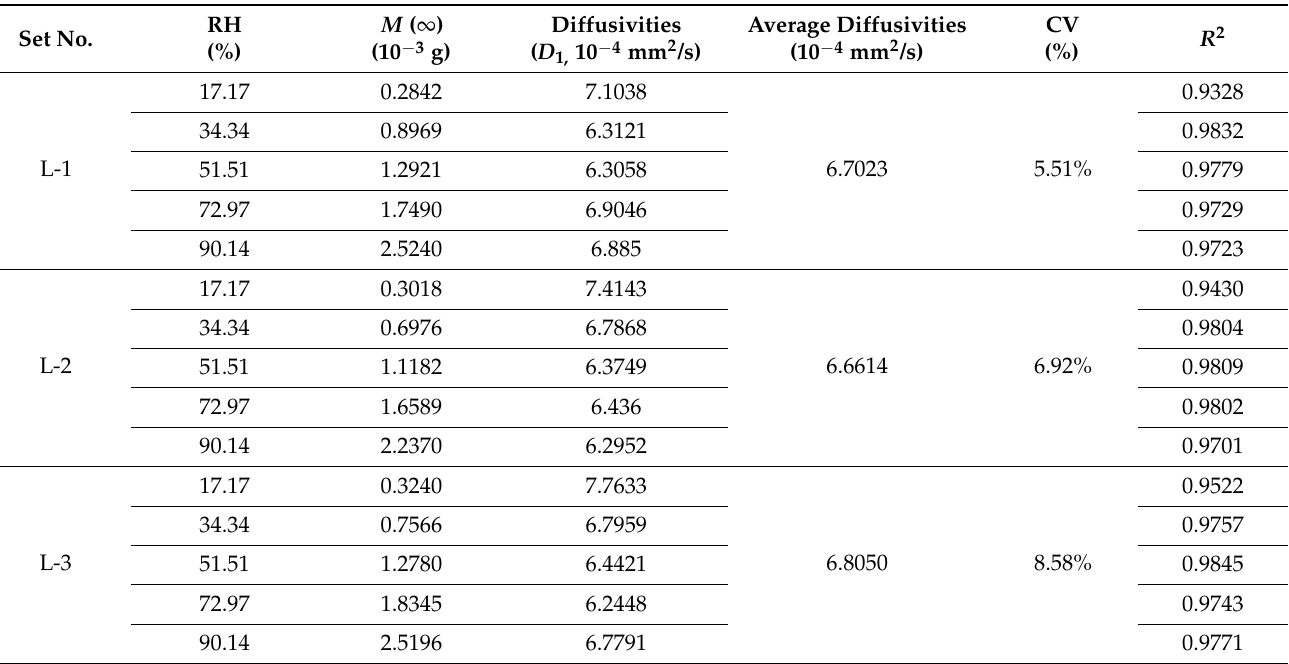
Table 4. Summary of the water and air movement parameters of the asphalt mixture for each relative